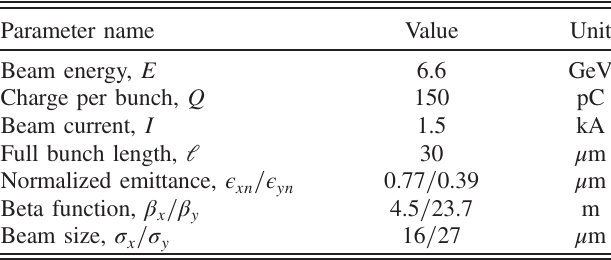
TABLE II. Selected LCLS beam and machine properties (at